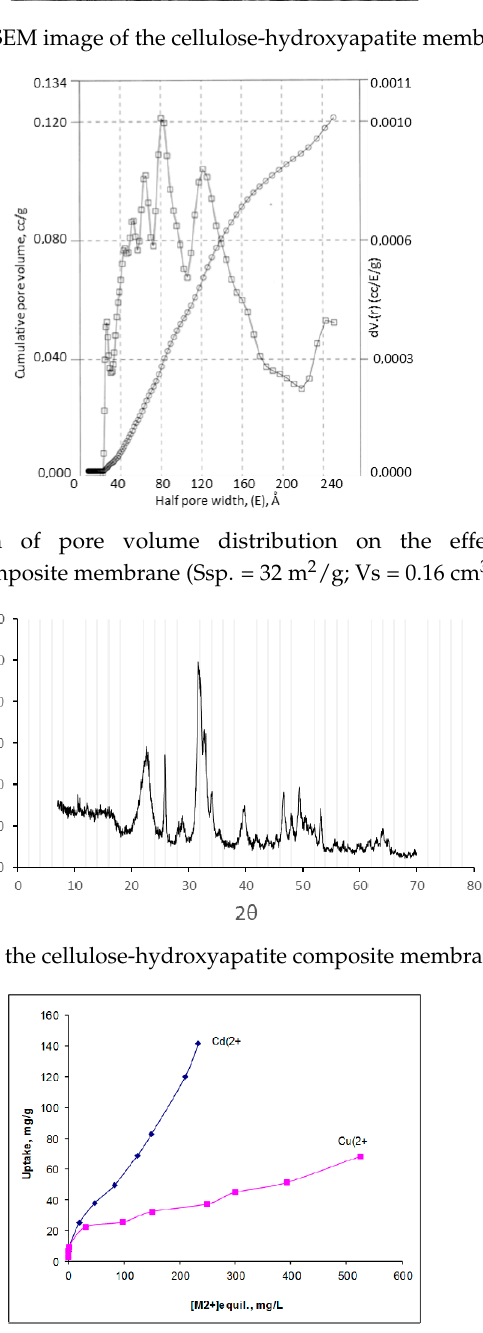
Figure 8. Isotherms of ion-exchange adsorption of cadmium and copper ions from polluted natural water S:L = 1:250; contact time 48 h at constant stirring.